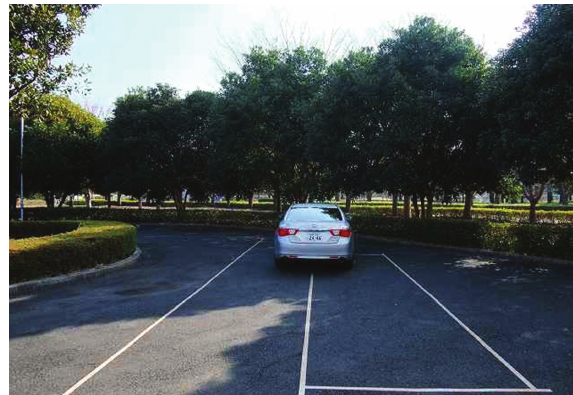
Figure 8: A radar target on a broadside in outdoor experiments.